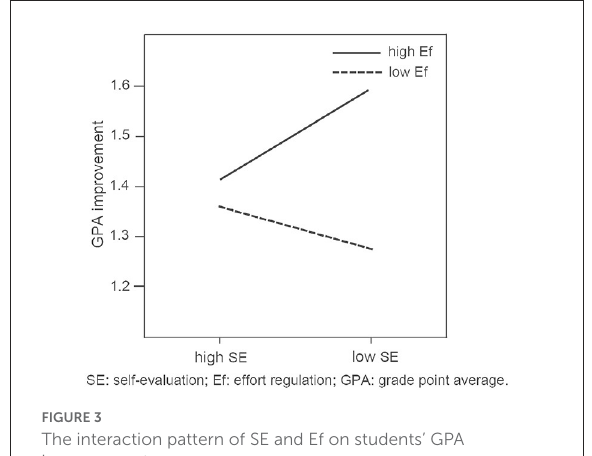
FIGURE3 The interaction pattern of SE and Ef on students’ GPA